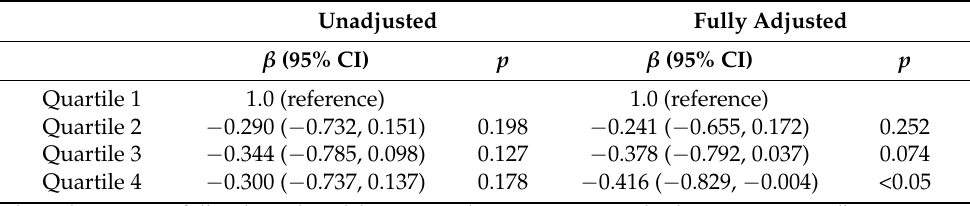
Table 5. Associations between serum selenium concentration and liver stiffness by quartile of serum selenium concentration (Quartiles